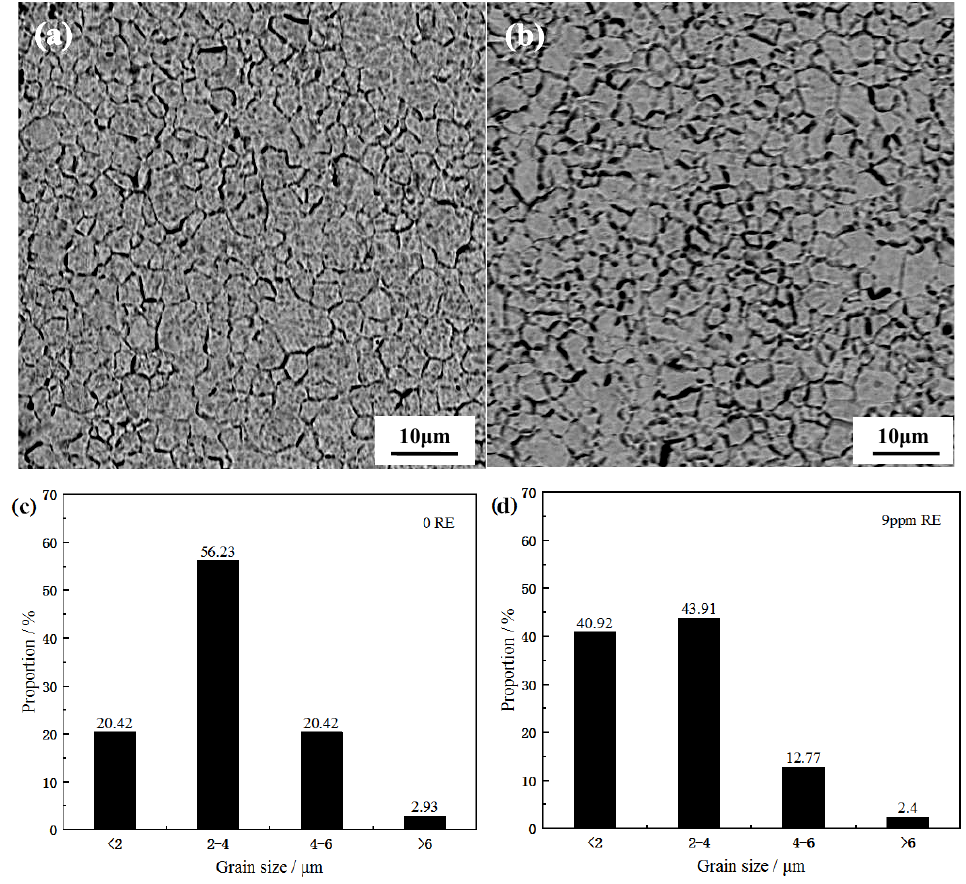
Figure 2. Original austenite microstructure and grain size distribution of two groups of experimental steels: ( a , c ) 0 RE and ( b , d ) 9 ppm RE.